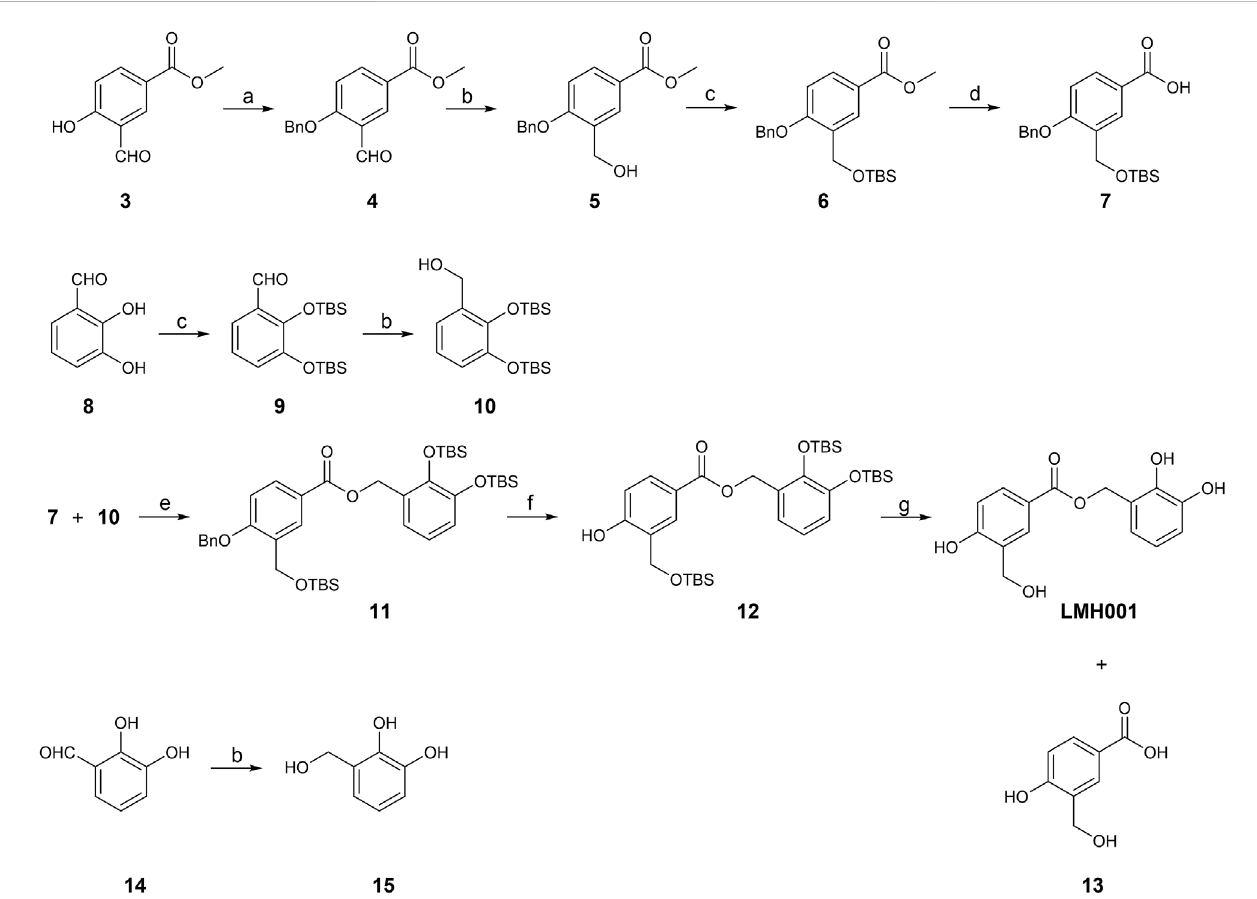
FIGURE 2 Synthetic scheme of LMH001 and its two breakdown products ( 13 and 15 ). Reagents and conditions: (a) benzyl bromide, Cs 2 CO 3 , anhydrous DMF, rt, 7.5 h, quantitative; (b) NaBH 4 , MeOH, 0 ° C or 0 ° C to rt, 12 h, 5% for 15 and quantitative for 5 and 10 (c) TBSCl, imidazole, DCM, rt, 12 h, 64% – 73% (for 6 , 9 ); (d) DCM, 3 M NaOH in MeOH, rt, 18 h, 66%; (e) DCC, DMAP, DCM, rt, 24 h, 60%; (f) H 2 (1 atm), 10% Pd/C, MeOH, rt, 1 h, 40%; (g) 1 M TBAF in THF, THF, 0 ° C to rt, 1 h,